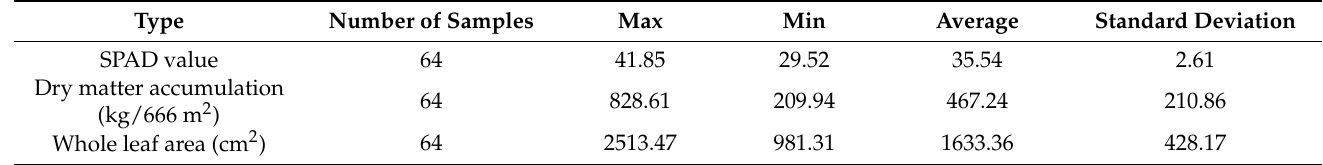
Table 1. Summary of physiological parameters of